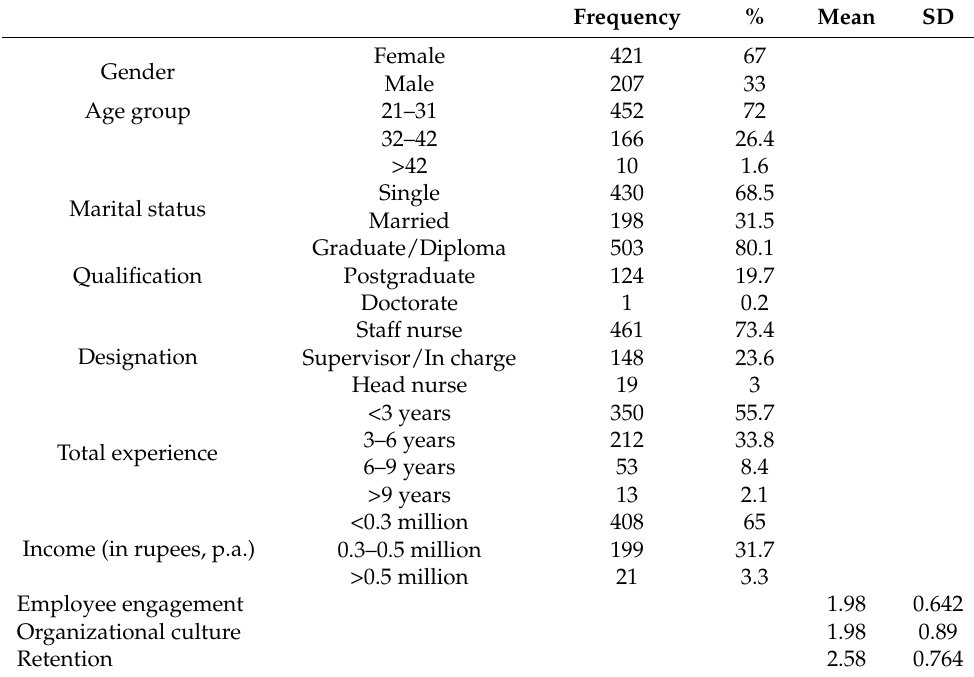
Table 1. Descriptive